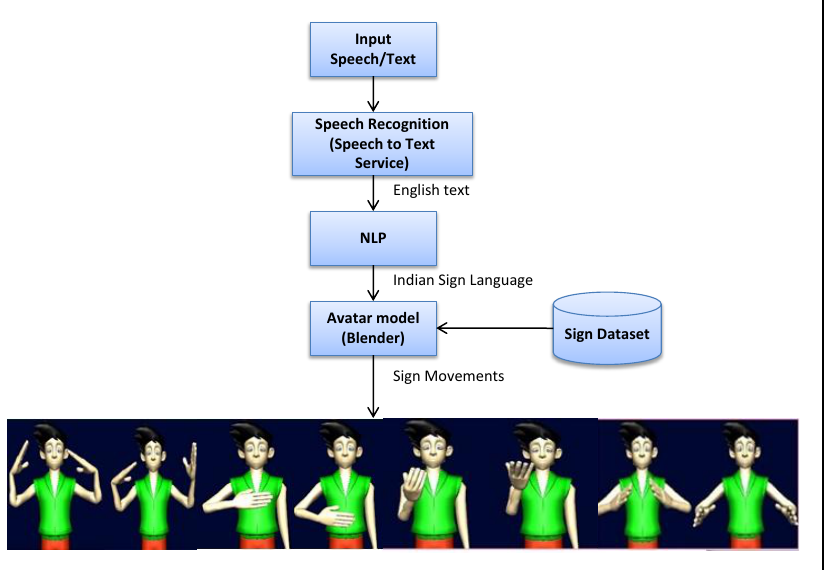
Figure 2. Framework of the proposed sign language learning system using text/speech. NLP: Natural Language